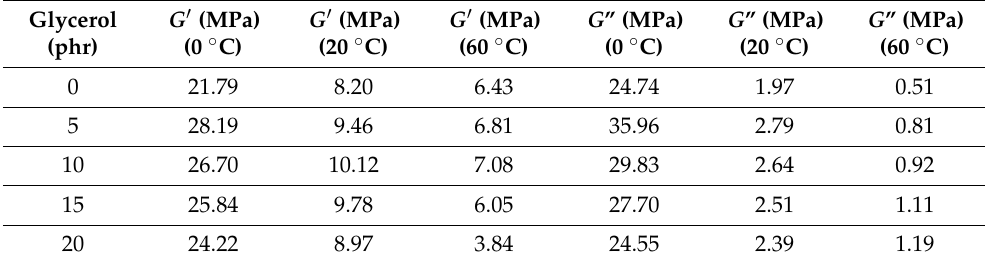
Table 2. Storage modulus ( G (cid:48) ) and loss modulus ( G ”) for vulcanizates based on NBR at different temperatures.